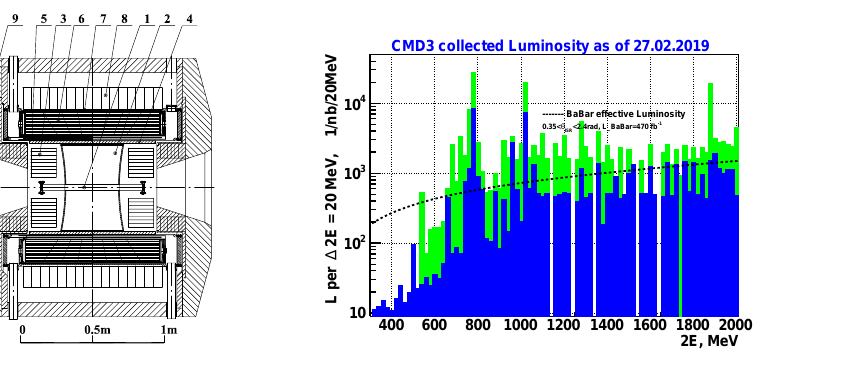
Figure 2. Luminosity collected by CMD-3. The ef- fective ISR luminosity of BaBar (the last competitor experiment) is shown for